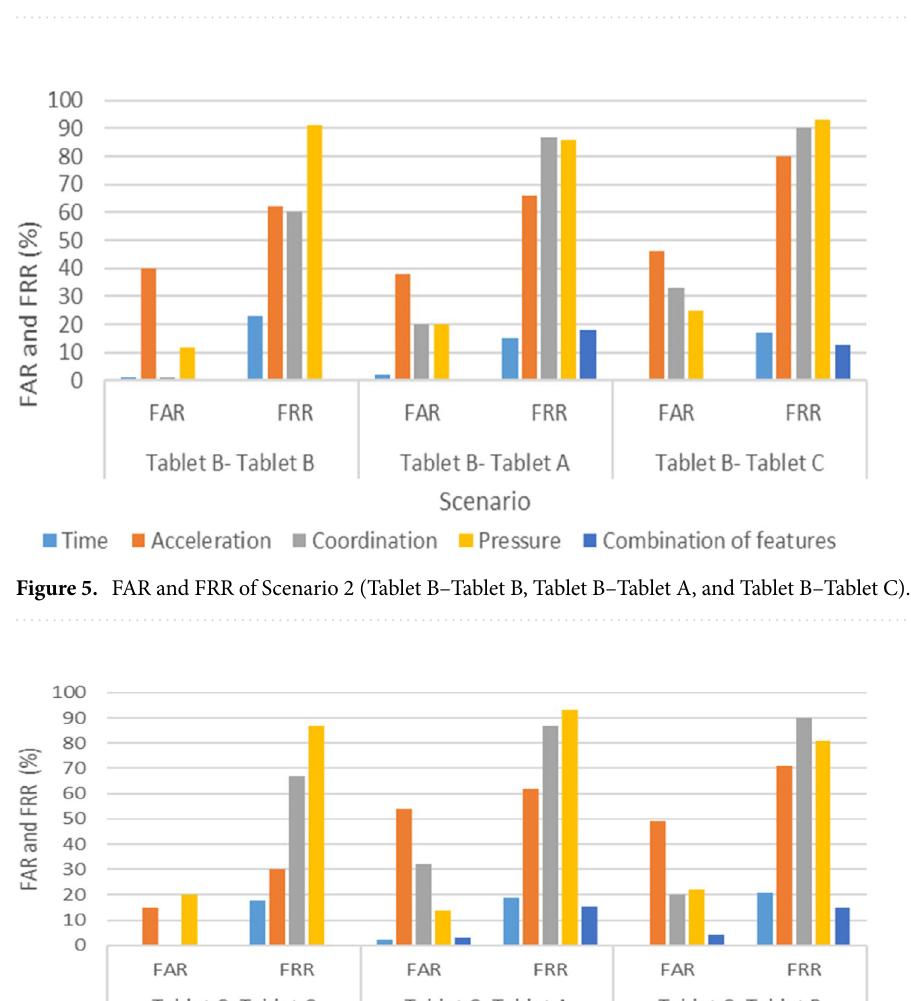
Figure 4. FAR and FRR of Scenario 1 (Tablet A–Tablet A, Tablet A–Tablet B, and Tablet A–Tablet C).